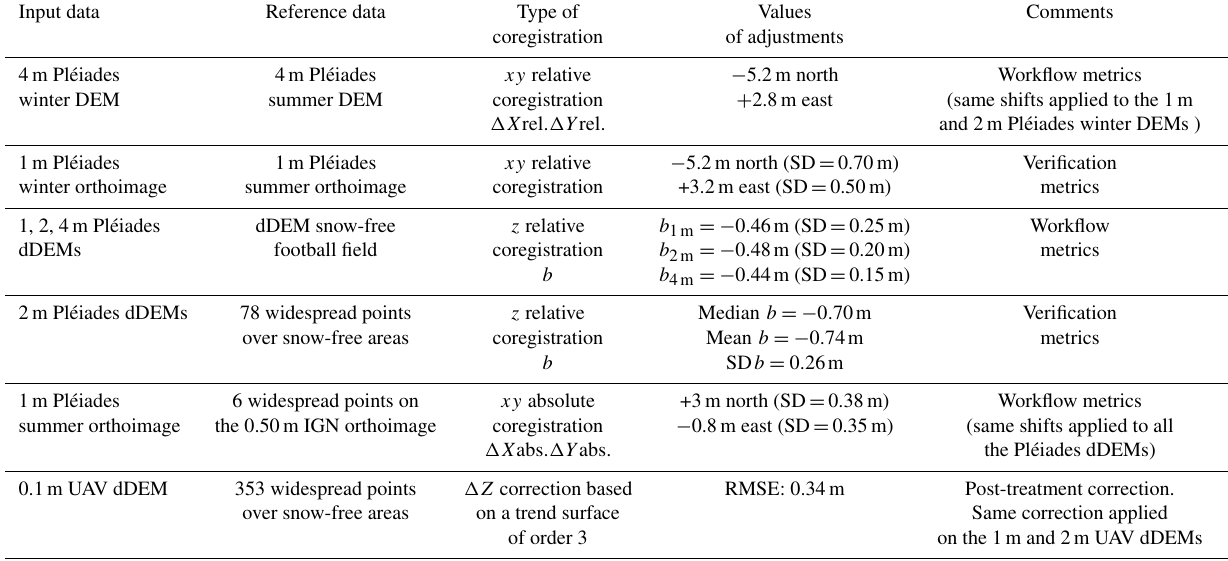
Table 2. Summary of the different co-registrations and bias corrections performed to produce the Pléiades and the UAV DEM and dDEM maps. SD means standard deviation. The term workflow metrics refer to the data presented in Fig. 3.